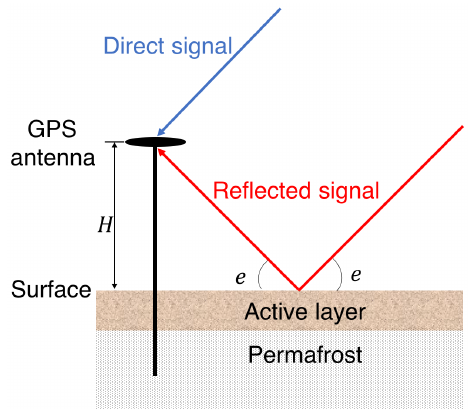
Figure 2. Schematic diagram showing the geometry of the GPS an- tenna, GPS signals, and the ground surface in permafrost area. H , or reflector height, is the vertical distance between the GPS antenna and the surface, and e is the satellite elevation